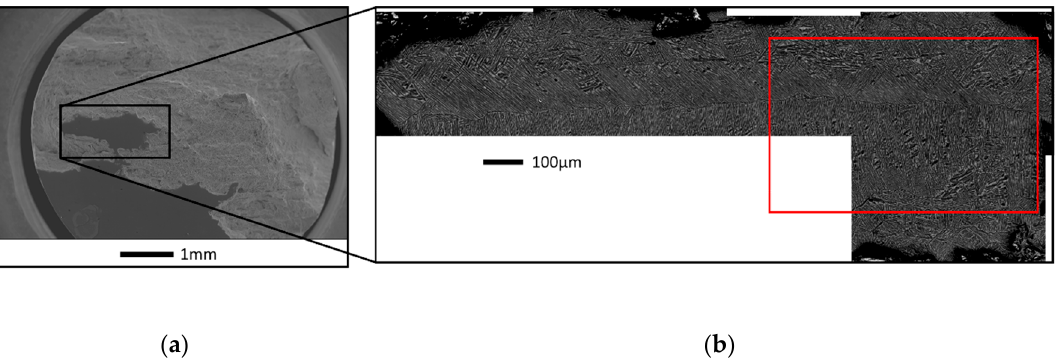
Figure 5. Fracture surface given in Figure 4 after polishing. ( a ) Macroscopic view; ( b ) Microstructure below the elongated facet seen Figure 4b, imaged with the BSE detector. The zone further analyzed by EBSD is boxed in red.